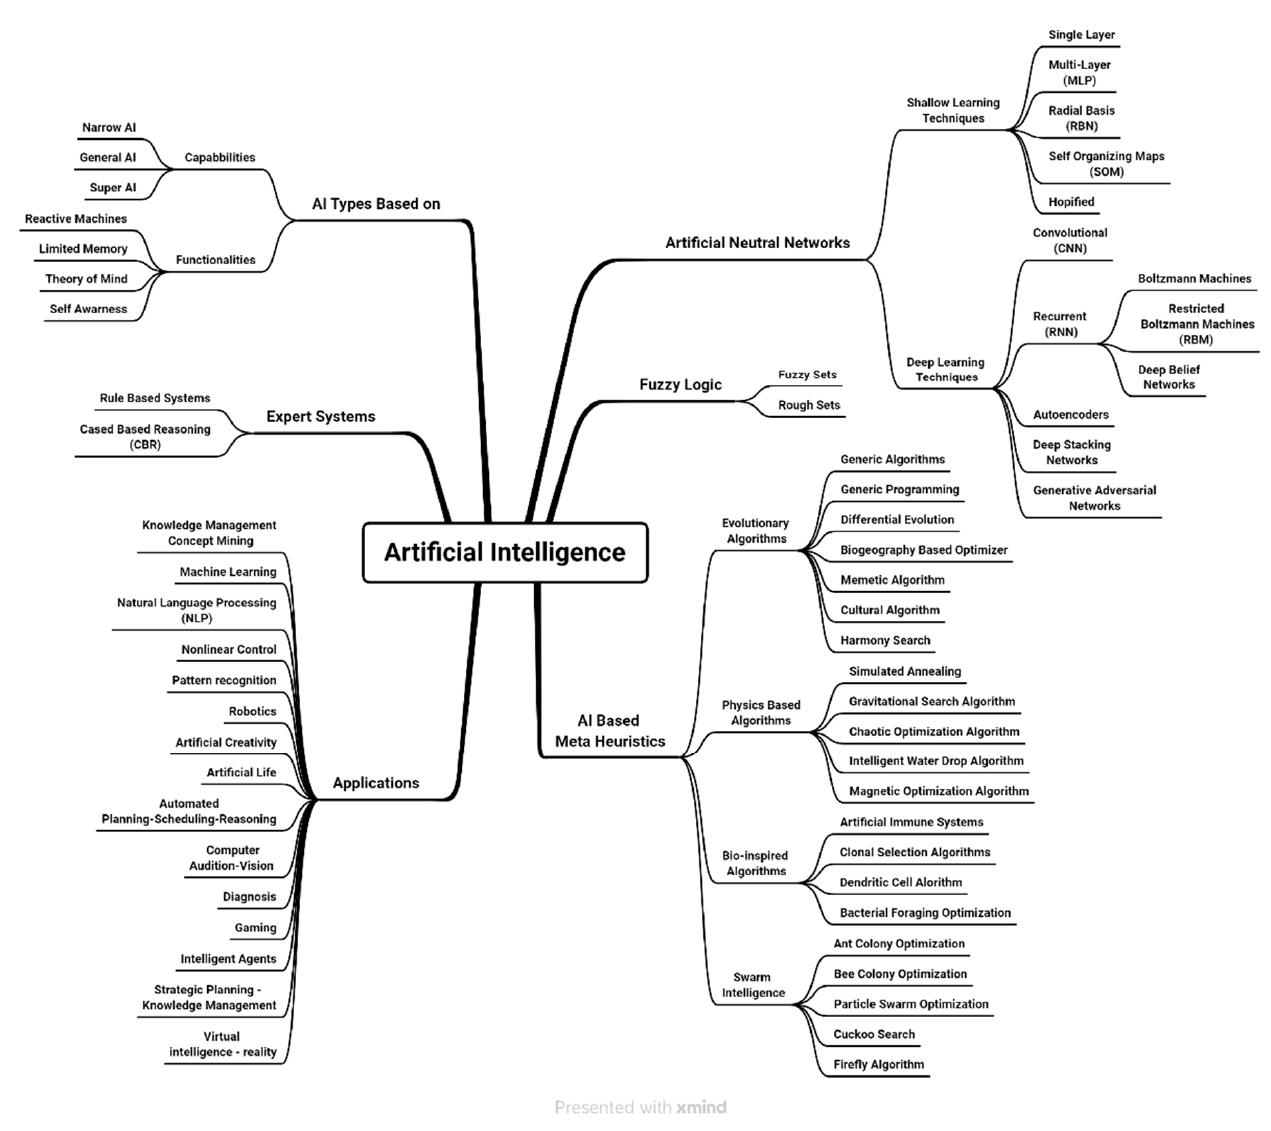
Figure 2. AI branches of types, applications, and techniques. Source: Own elaboration.